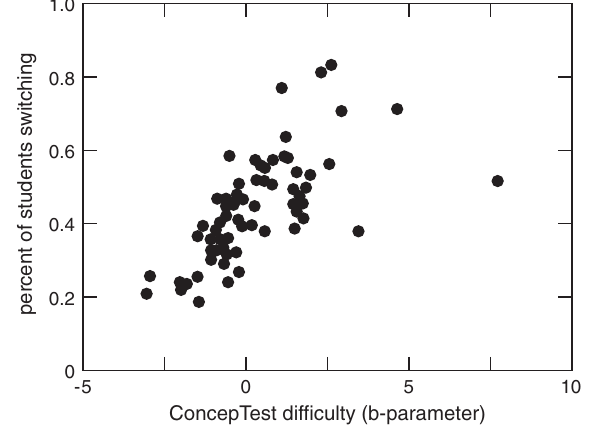
FIG. 5. Fraction of students who switch (in any of the three directions) plotted for each individual ConcepTest as a function of CT difficulty (obtained from a 2PL item response theory